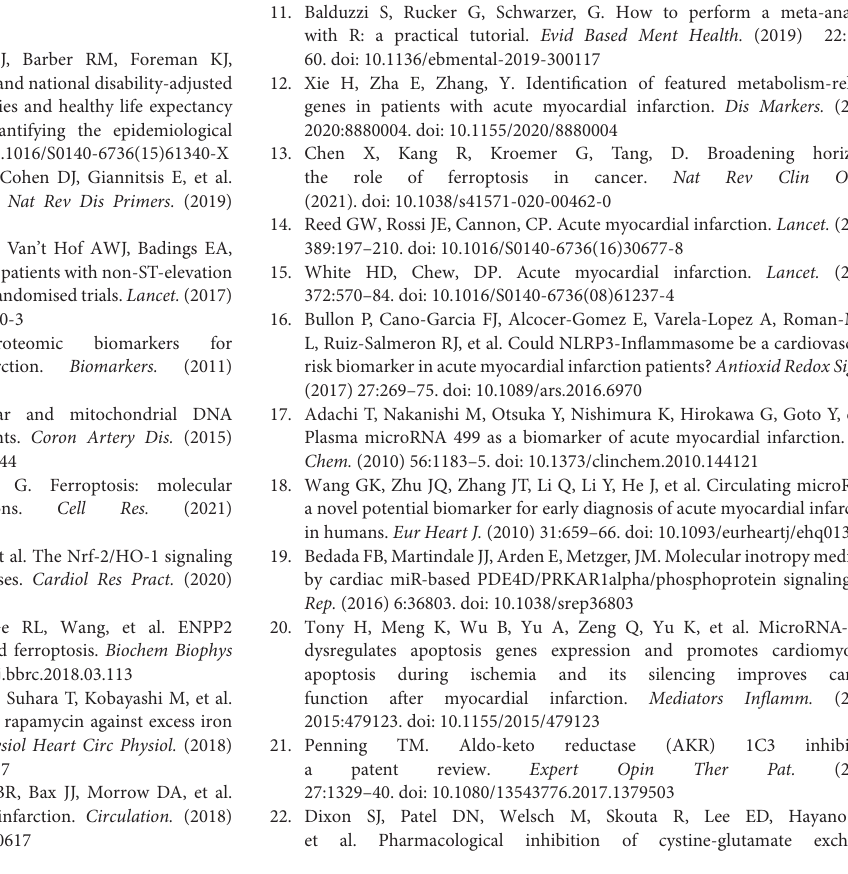
Supplementary Table 2 | The predicted transcription factors. Supplementary Table 3 | The correlation between AKR1C3 and candidate transcription factor. Supplementary Table 4 | The results of the luciferase reporter assay. Supplementary Table 5 | The differentially expressed genes in GSE48060. Supplementary Table 6 | The correlation among genes, modules, and logical score. Supplementary Table 7 | The GSEA results for AKR1C3. Supplementary Table 8 | The GSEA results for HOXB4. Supplementary Table 9 | The correlation between each gene and logical score. Supplementary Table 10 | The potential compounds obtained from CMap. Supplementary Table 11 | The primers of the gene for RT-qPCR